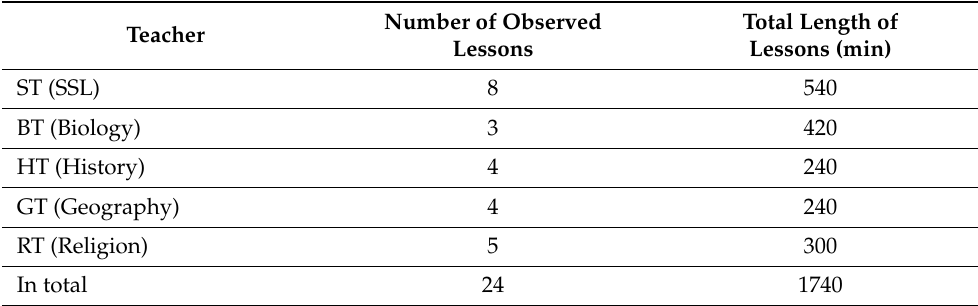
Table 1. Overview of the